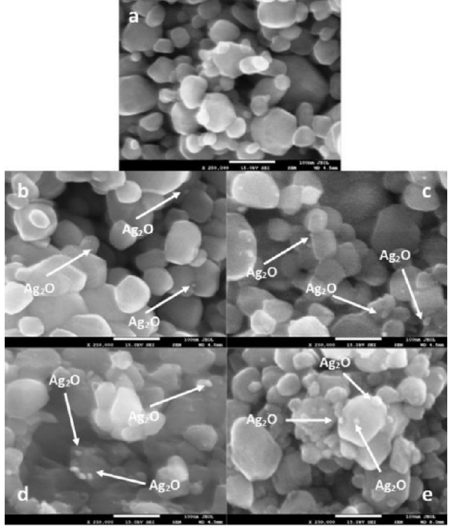
Figure 20. FE–SEM of ( a ) pure WO 3 and ( b – e ) Ag + impregnated WO 3 [32]. Reproduced with per- mission from Hameed et al. Copyright © 2022 Elsevier.